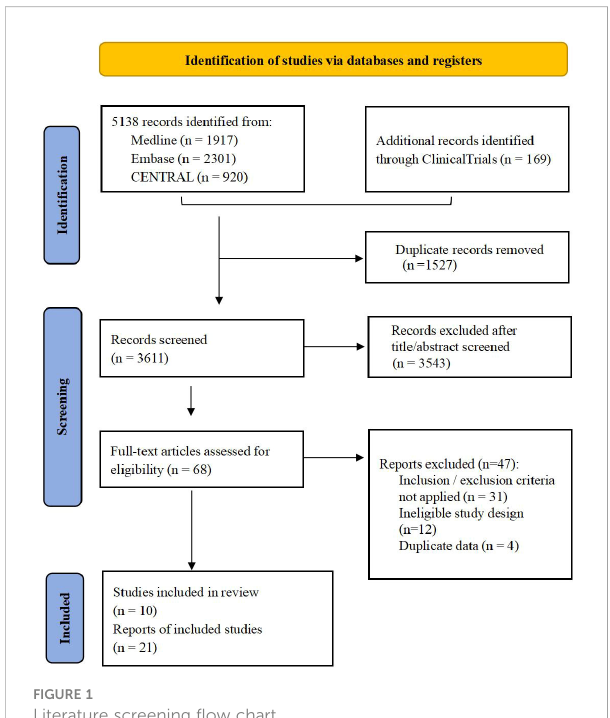
FIGURE 1 Literature screening fl ow